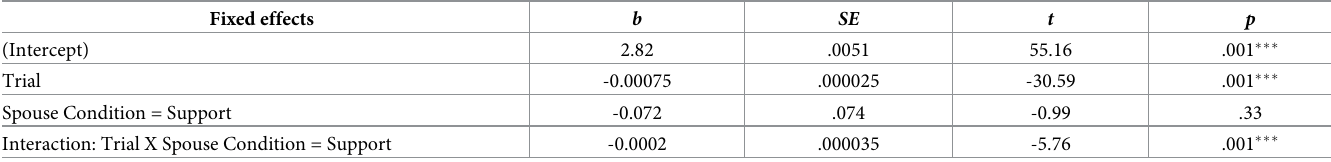
Table 3. Model output of the analysis of tonic pupillary response.